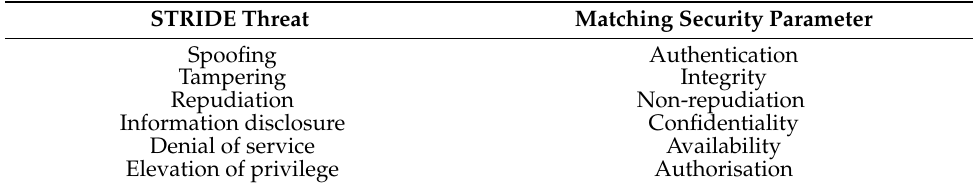
Table 2. STRIDE security